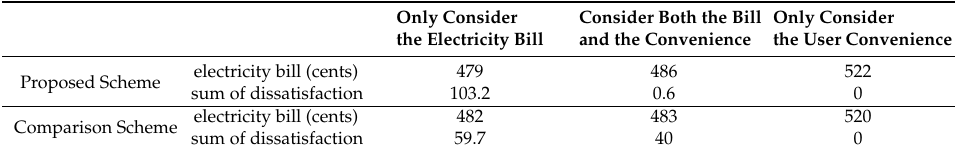
Table 2. Sum of the electricity bill and the